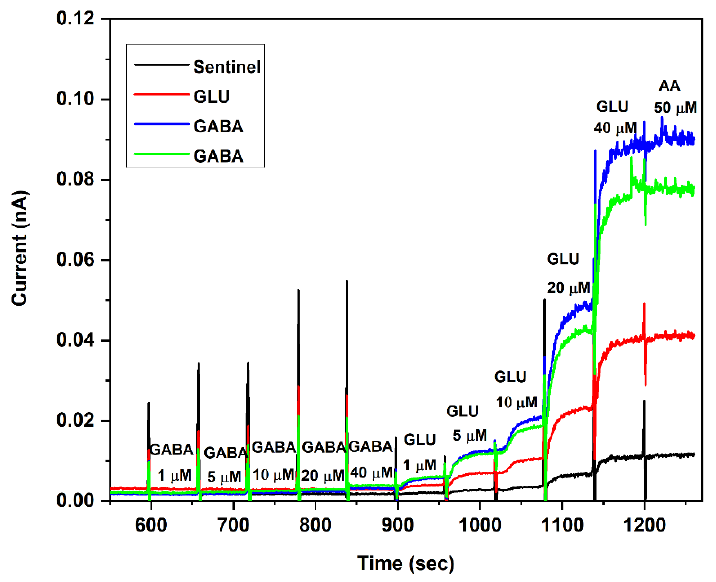
Figure 5. In vitro calibration of GLU and GABA microbiosensors for sensitivity and selectivity measurements. The GOx and GABASE concentrations were 0.1 U/ µ L each, respectively. The mPD is coated at the optimal conditions. The experiments were carried out in 100 μ M α -ketoglutarate +1X PBS. The microbiosensors were biased at + 0.7 V vs. Ag/AgCl reference. The solution was stirred at 200 rpm and maintained at 37 °C.